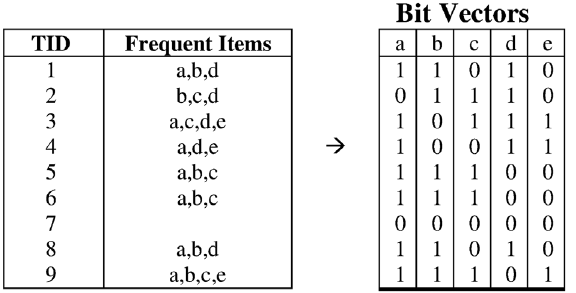
Figure 2. Bit Vectors Constructed from the Data Set in in Table